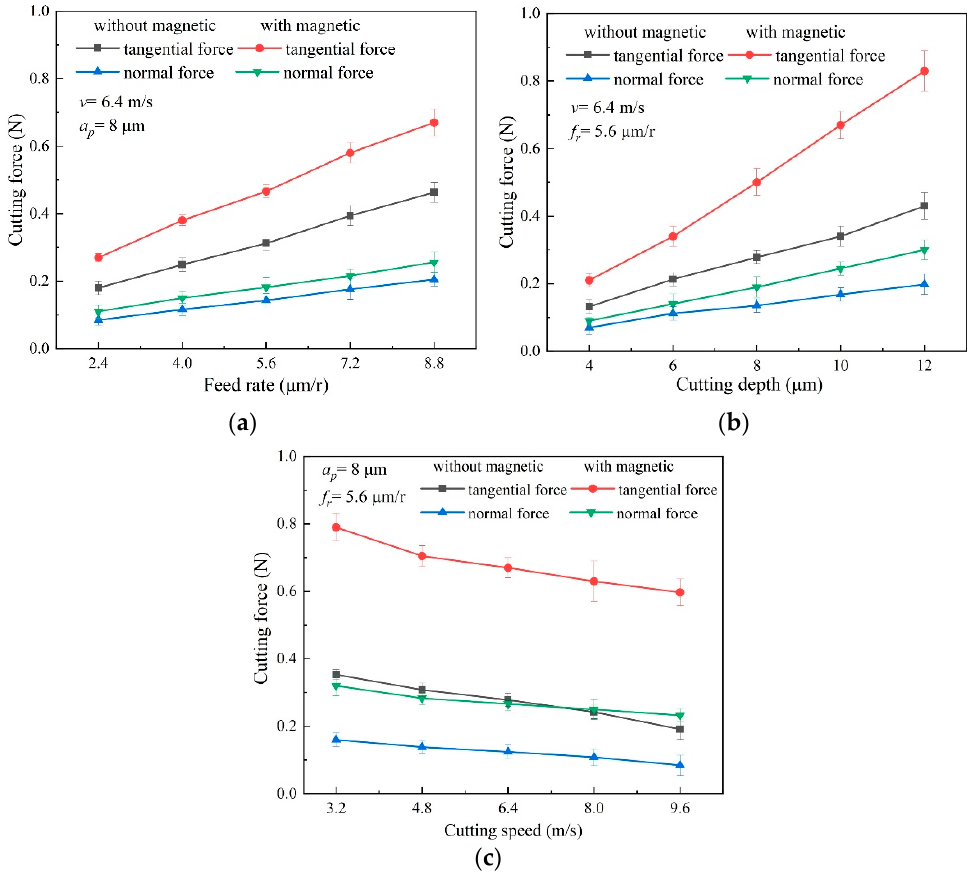
Figure 6. Effect of magnetic-field action on cutting force, ( a ) variation of cutting force with feed rate, ( b ) variation of cutting force with depth of cut, ( c ) variation of cutting force with cutting speed.